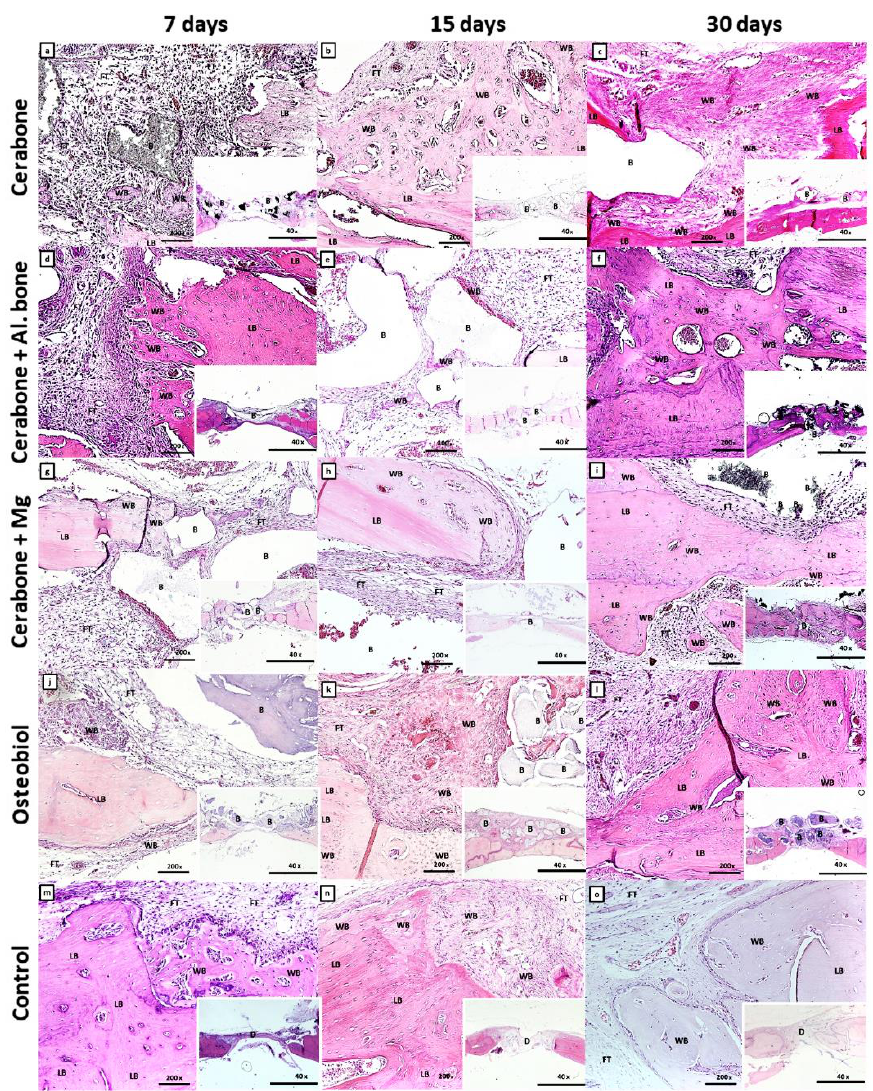
Figure 2. Microphotographs of the coronal sections of rat calvarial bone defects with implanted biomaterials: Cerabone ® ( a – c ); Cerabone ® + Al. bone ( d – f ); Cerabone ® + Mg ( g – i ); Osteobiol